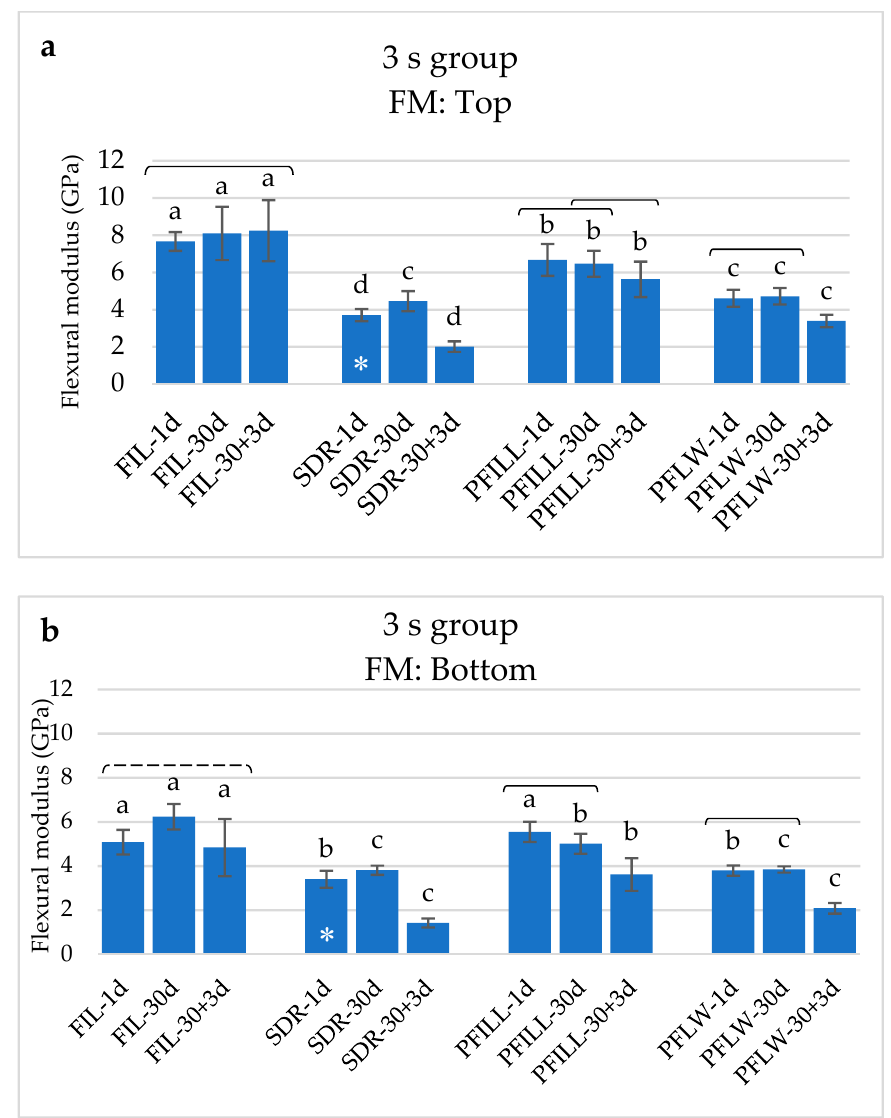
Figure 6. Flexural modulus (mean values ± 1 standard deviation) for materials polymerized with 3 s protocol: ( a ) top specimens, ( b ) bottom specimens. The same letters show statistically homogeneous groups for a particular time point. Brackets indicate statistically homogeneous groups for each material ( p < 0.05). Dashed brackets indicate statistically homogeneous groups for a particular material, which are not similar to the column in between (in cases where the time dependence is not monotonous), p < 0.05. Asterisk denotes no statistically significant differences between top ( a ) and bottom specimens ( b ) of the same material and time point.